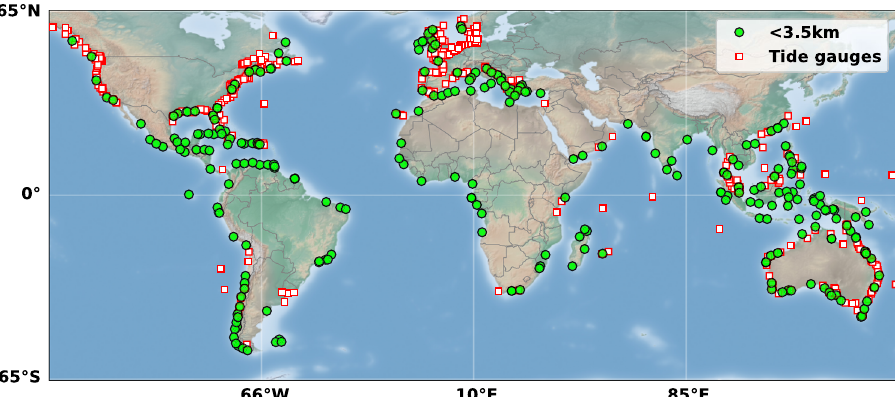
Fig. 8 Network of 271 virtual coastal stations located within 3.5 km from the coast (green dots). Red/white squares correspond to tide gauges having monthly data over January 2002-December 2019 (with only 24 months of missing data; 400 sites) (tide gauge data are downloaded from the Permanent Service for Mean Sea level 25